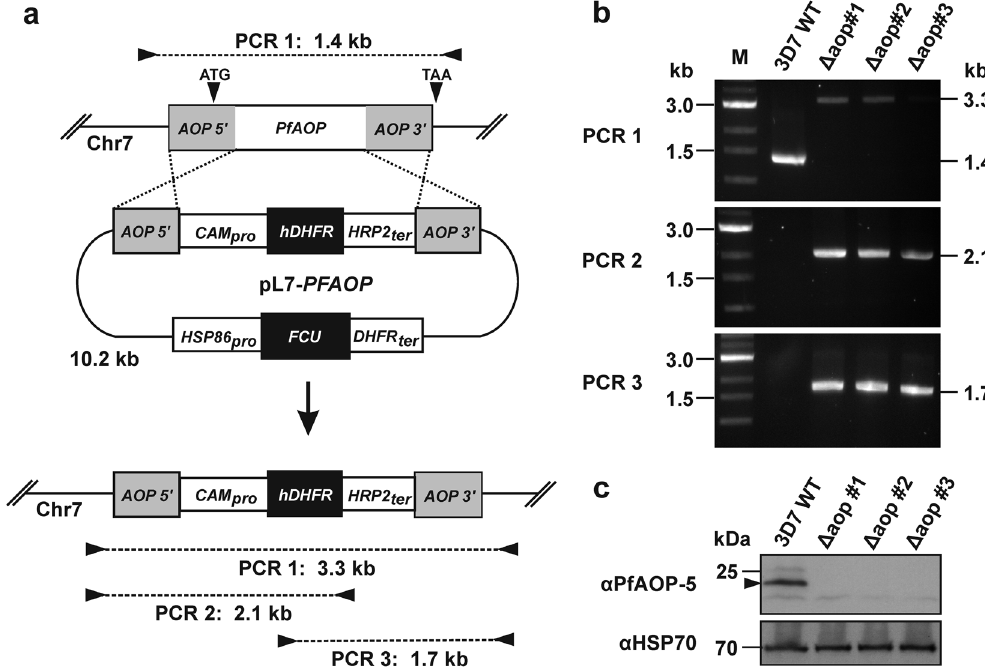
Figure 4. Generation and validation of Δ pfaop knockout parasites. ( a ) Schematic summary of the knockout strategy by double crossover using the plasmid pL7- PFAOP . Expected product sizes from analytical PCR reactions 1–3 are highlighted. The two external primers should anneal to chromosome 7, whereas the two internal primers should anneal to the gene that encodes the selection marker human dihydrofolate reductase (hDHFR). ( b ) Following the genetic manipulation of the wild type strain 3D7 (3D7 WT) and isolation of three clonal cell lines ( Δ aop#1-3), products from PCR reactions 1-3 were analysed by agarose gel electrophoresis. Marker (M) and expected product sizes are indicated on the left and right side, respectively. ( c ) Western blot analysis of parasite cell lines Δ aop#1-3. Protein extracts from 10 7 parasites were loaded per lane. Hsp70 was decorated as a